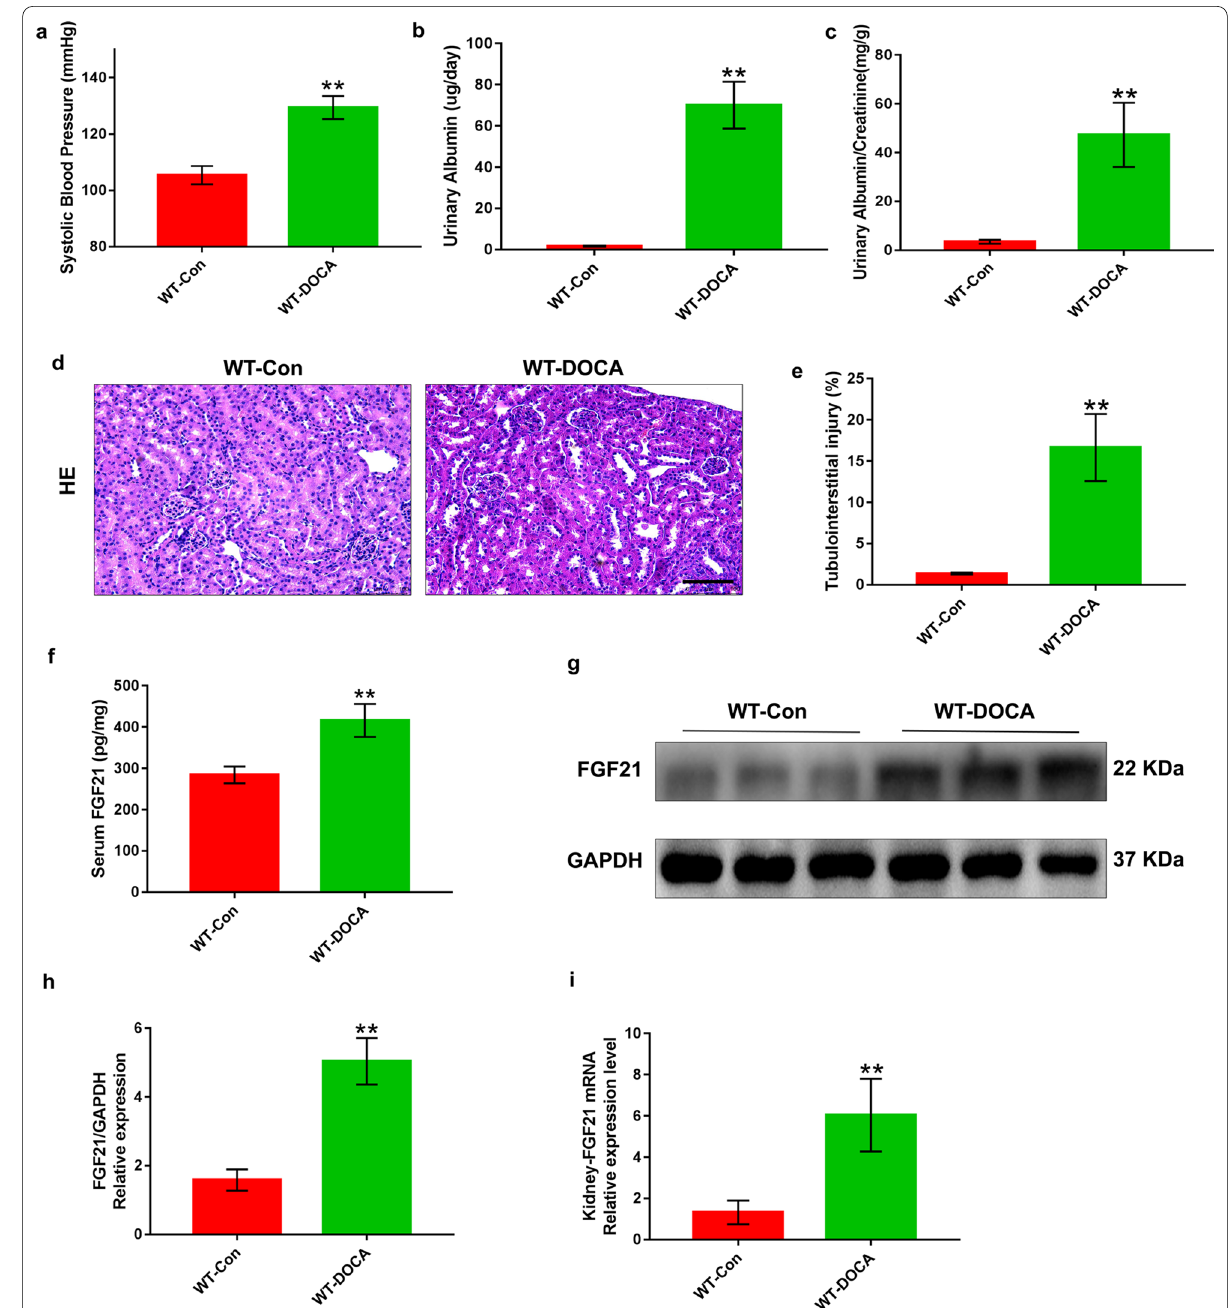
Fig. 1 Treated with DOCA‑salt for 8 days induced SSHN and increased expression of FGF21 in mice. Eight‑week‑old male FGF21 wild type (WT) mice based on C57BL/6J were treated with DOCA‑salt or sham operation as controls. a The systolic blood pressure was monitored by a tail‑cuff in DOCA‑salt‑induced hypertensive mice. b and c Urinary albumin levels and urinary albumin/creatinine ratio were elevated by treatment with DOCA‑salt for 8 days. d and e Representative images of Hematoxylin–eosin‑stained kidney sections showed obvious tubulointerstitial injury evidenced by aggravated epithelial cell necrosis and interstitial oedema in DOCA‑salt‑treated mice compared with that in the controls. f Serum FGF21 levels in the control and DOCA‑salt‑treated mice were determined by ELISA. g and h The changes of renal FGF21 expression in mice after treated with DOCA‑salt for 8d using Western blot. GAPDH was used as loading and normalization control. i FGF21 mRNA expression in kidney tissues for the control and DOCA‑salt‑treated mice by Q‑PCR analysis and values normalized to GAPDH. Quantitative data are presented as mean SD, n 6 mice/group. *P < 0.05, **P < 0.01 versus the control group. Scale bar: 100 ± =